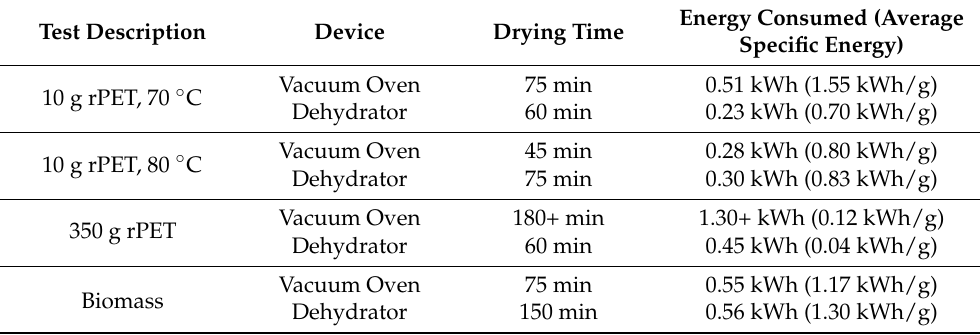
Table 6. Summary of the test results.